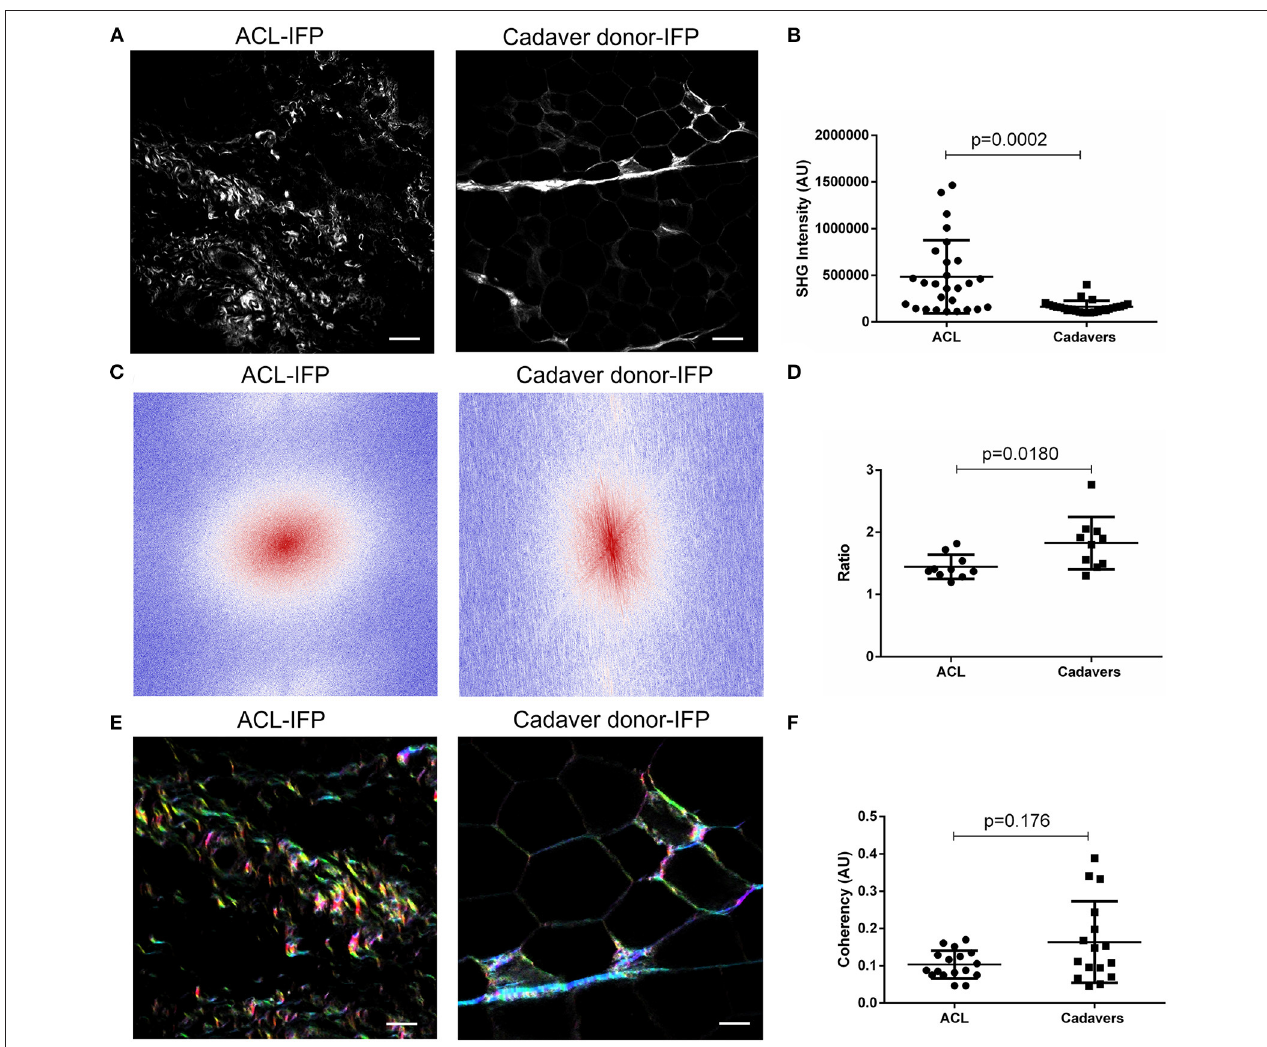
FIGURE 4 | Evaluation of collagen content and distribution. (A) Representative images of ACL-IFP and cadaver donor-IFP samples after label-free Second Harmonic Generation (SHG) collagen analysis (scale bar = 50 µ m). (B) SHG intensity evaluation: a significant difference ( p = 0.0002) was detected for total collagen content in the cohort, with higher values in the ACL-IFP group than in the cadaver donor-IFP group. (C) Fast Fourier Transforms (FFTs) applied to ACL-IFP and cadaver donor-IFP samples showing a circular and an oval collagens orientation for ACL-IFPs and cadaver donor-IFPs, respectively. (D) FFT power plots in (C) were fitted with an ellipse and the ratio of long and short axis is reported. (E) Hue, Saturation and Brightness (HSB) maps obtained through the OrientationJ plugin for the ACL-IFP and cadaver donor-IFP samples; in these maps, to an orientation angle of the collagen is assigned a color and a specific color saturation (scale bar = 100 µ m). (F) Coherency analysis did not show significant differences in the